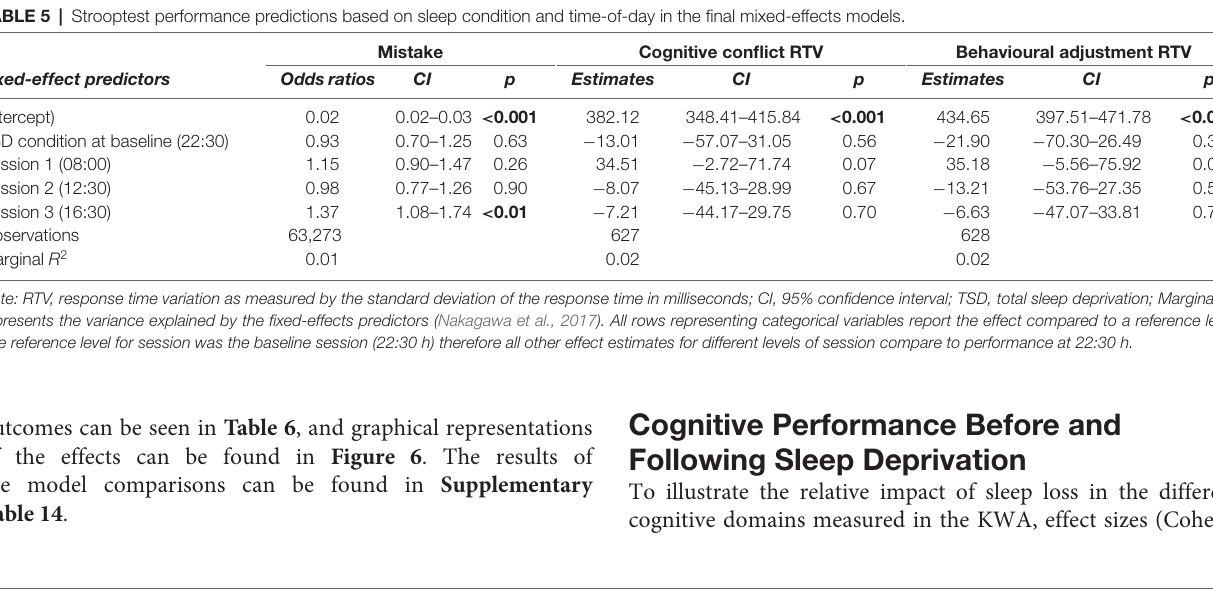
To illustrate the relative impact of sleep loss in the different cognitive domains measured in the KWA, effect sizes